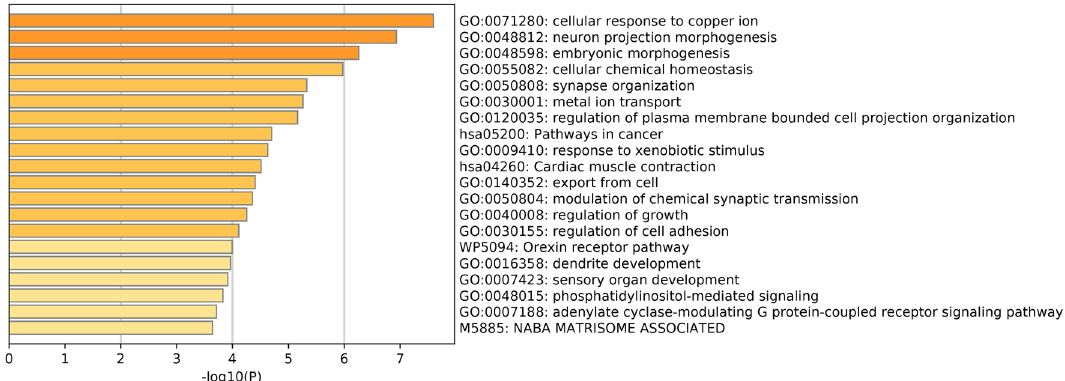
Figure 7. Enrichment analysis in the Cuproptosis-related lncRNA